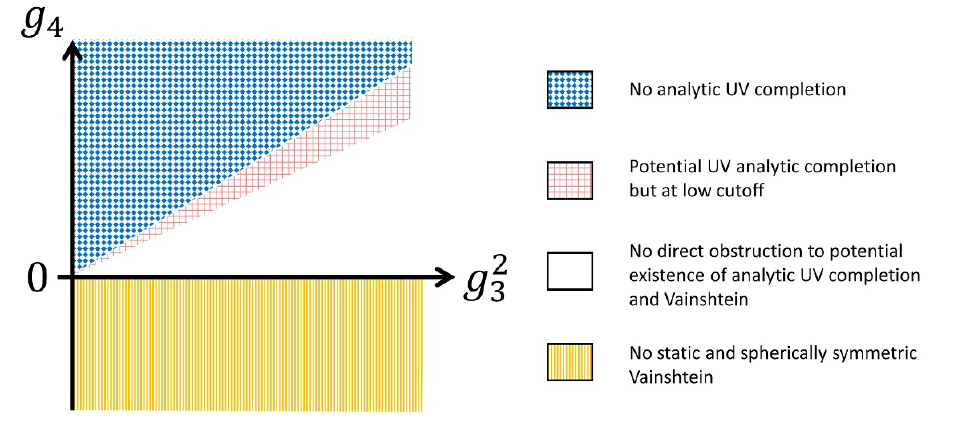
Figure 1 . Summary of constraints imposed on coe(cid:14)cients of cubic ( g 3 ) and quartic ( g 4 ) Galileon operators to respect known bounds imposed by (1). the existence of a hypothetical local, analytic UV completion, (2). a cuto(cid:11) which is above the Galileon mass, and (3). the existence of a static and spherically symmetric Vainshtein mechanism. The boundary between no analytic Wilsonian UV completion and a potential UV completion with an unacceptably low cuto(cid:11) is at g 4 = 7 = 8 g 2 For g 4 < 3 = 4 g 2 there is to date no known obstruction for the potential existence of an analytic UV 3